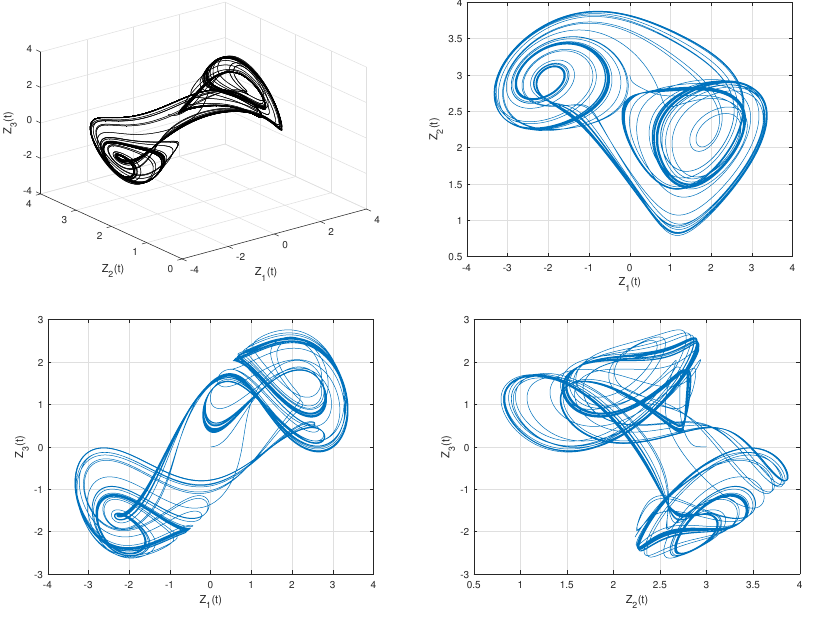
Figure 2. Phase diagrams of